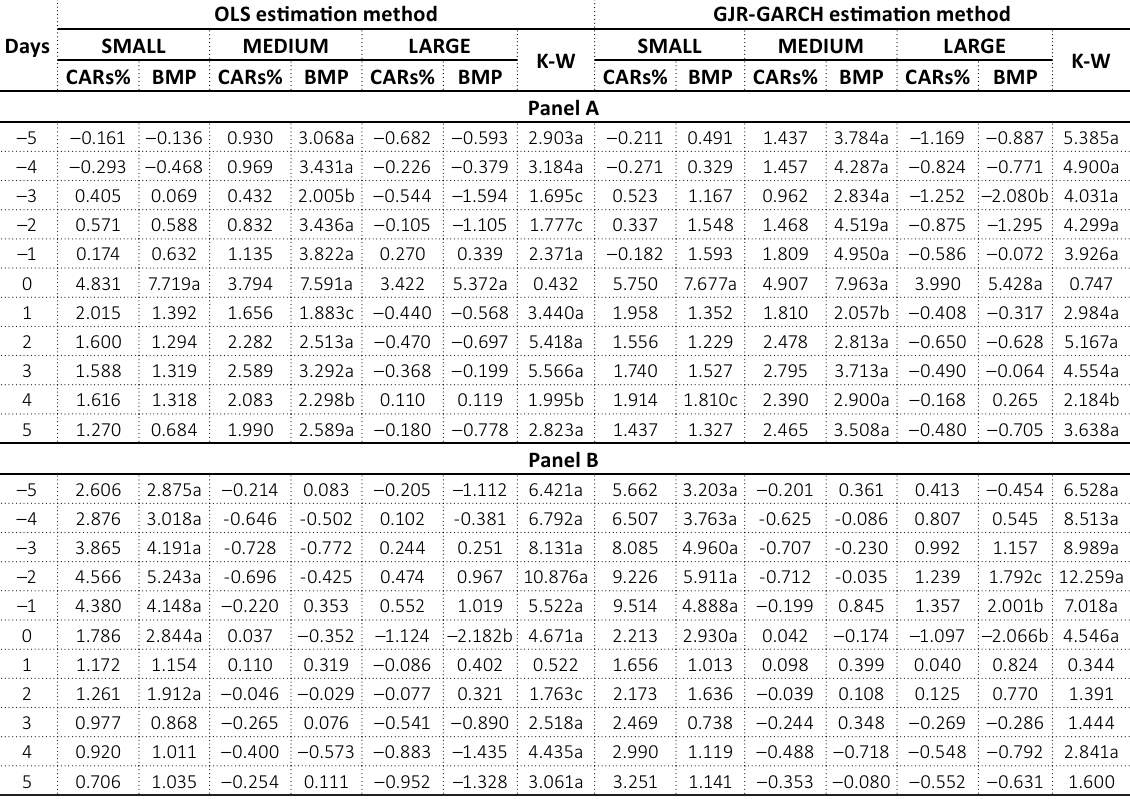
Table 3. Cumulative ARs measures around mergers announcements group by market capitalization value for target and acquirer firms OLS estimation Days